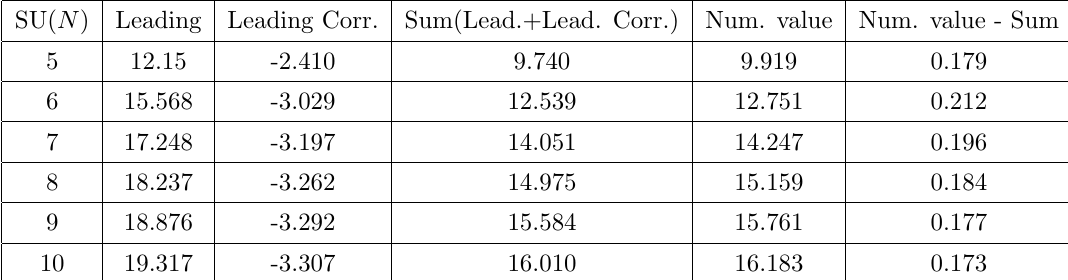
N 10). (cid:20) (cid:20)